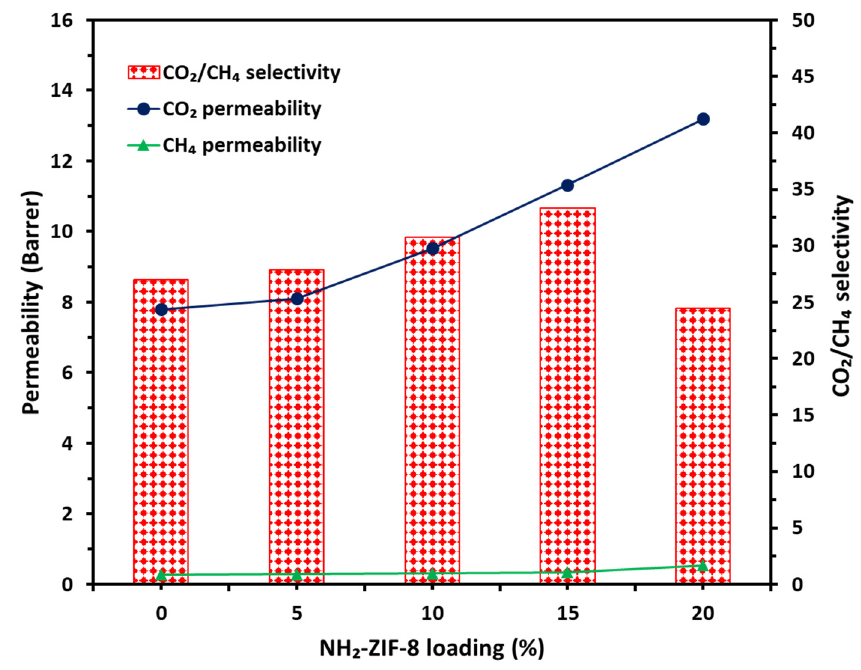
Figure 7. Separation performance of fabricated membranes as a function of NH ₂ -ZIF-8 loading.